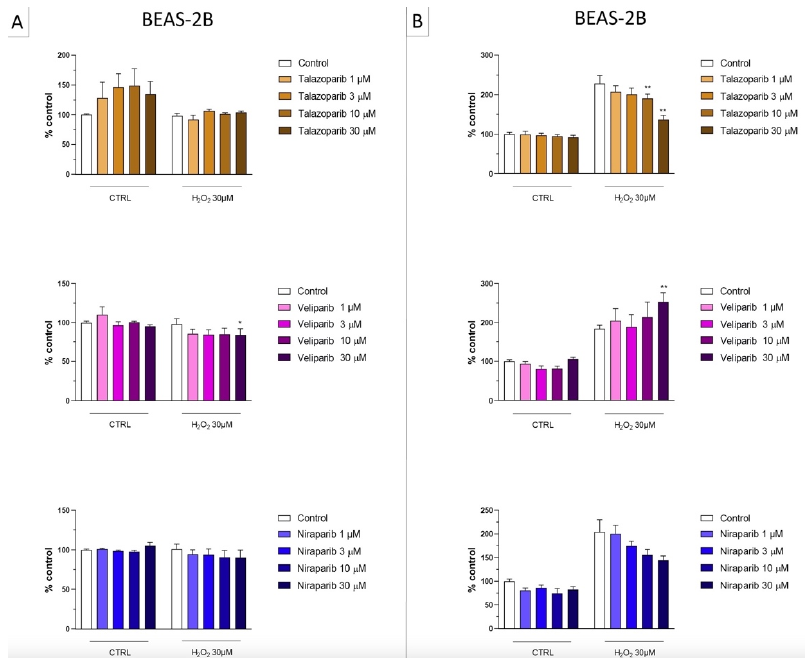
Figure 9. Effect of the clinical-stage PARP inhibitors talazoparib, veliparib, or niraparib on H 2 O 2 - induced cell necrosis in BEAS-2B cells. Cells were treated for 2 h ( A ) or 24 h ( B ) with 30 µM H 2 O 2 ; the PARP inhibitors were applied at different concentrations (1, 3, 10, and 30 µM). Cell necrosis was measured by measurement of LDH levels in the supernatant. * p < 0.05 and ** p < 0.01 indicate the effect of PARP inhibition in oxidatively stressed cells. Data are shown as mean ± SEM of n = 5 inde- pendent experiments. Because of the well-known role of PARP in the recruitment of DNA repair enzymes and in the maintenance of genetic integrity, the effect of two selected PARP inhibitors, olaparib and rucaparib, was also tested on DNA integrity. DNA damage in response to the H 2 O 2 challenge (600 µM in U937 cells and 30 µM in BEAS-2B cells) was comparable in both cell types studied and induced approximately 2–3-fold increases in DNA strand breakage over baseline levels. The PARP inhibitors, at the concentrations where they exerted cytoprotective effects in the MTT and LDH assays (3 and 30 µM), did not potentiate the degree of H 2 O 2 -induced DNA damage, but, in fact, unexpectedly, reduced the degree of DNA damage both in U937 cells (Figure 10A) and in BEAS-2B cells (Figure 10B), although in some instances clear concentration-dependence of the response was not observed. Importantly, none of the PARP inhibitors used increased/potentiated the DNA dam- age induced by the oxidant.